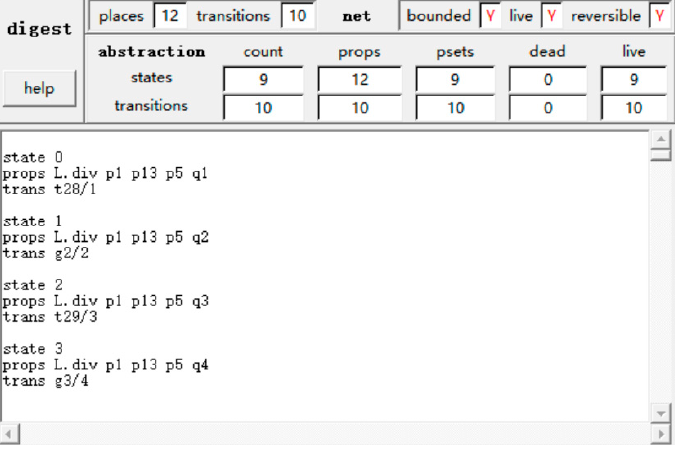
Figure 11. Veri fi cation result of the boundedness and liveness of Σ (cid:2870) = {𝑁 (cid:2870) ,𝐹 (cid:2870) , 𝐺 (cid:2870) , 𝑀 (cid:2870) } .